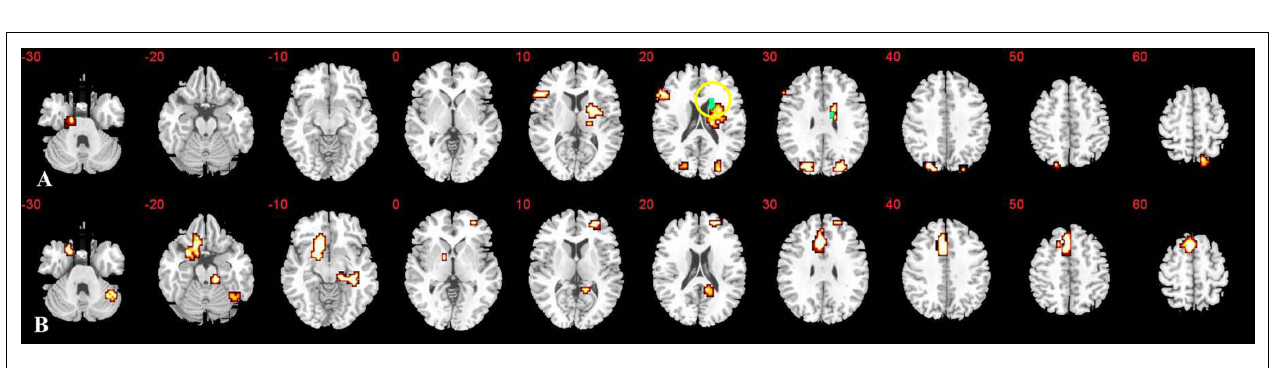
cluster levels). Slices are marked with the z coordinate as distance in millimeters from the anterior–posterior commissure. Blue regions show caudate activation also directly related to performance as demonstrated by conjunction analysis.